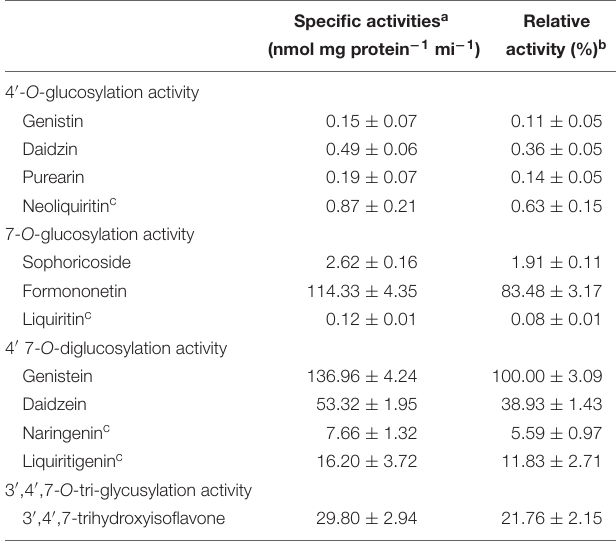
TABLE 1 | Enzyme activity of recombinant